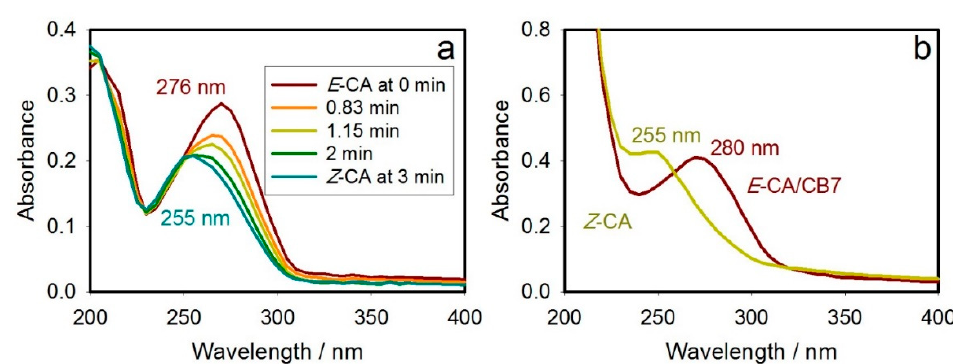
Table 2. Absorption features of E and Z isomers of CA in water at pH 6 and 298 K.